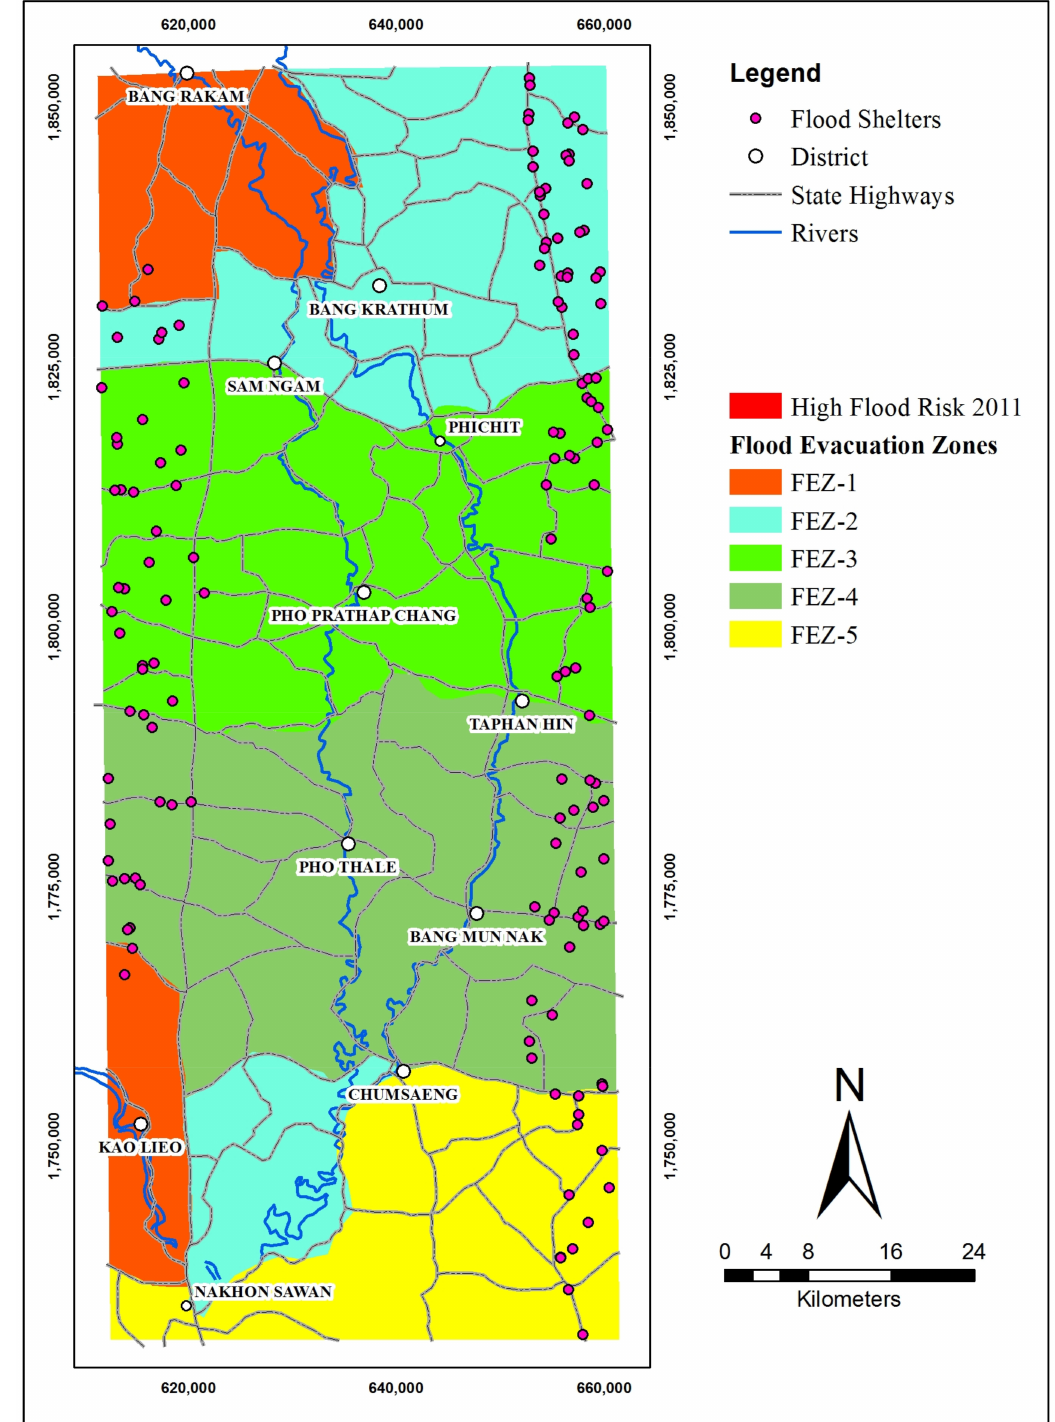
Figure 6. Flood evacuation zones for the middle